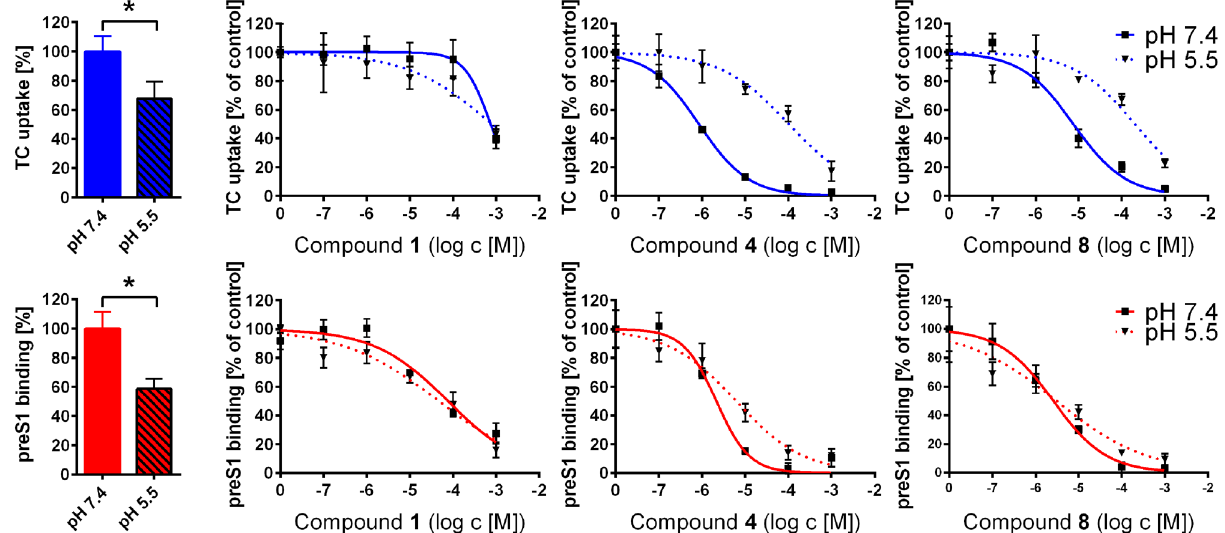
Figure 4. Influence of pH on the inhibition pattern of acidic betulin derivatives. NTCP-HEK293 cells were incubated with tetracycline in order to induce NTCP expression and were used for bile acid transport experiments with 1 µM [ 3 H]TC and for myr-preS1 2-48 lipopeptide binding experiments with 5 nM [ 3 H]preS1, each over 10 min at 37 °C. Cells without tetracycline treatment served as control (set to 0%). Experiments were performed with solvent alone (set to 100%) and with increasing concentrations of the indicated inhibitors in the range of 0.1 to 1,000 µM at pH 7.4 and pH 5.5, respectively. Diagrams show inhibition curves at pH 7.4 (solid lines) and pH 5.5 (dashed lines). The mean of the 0% control was subtracted to calculate net [ 3 H]TC transport rates (shown in blue) as well as net [ 3 H]preS1 binding rates (shown in red), both expressed as % of control at the y-axis. Bar graphs show the relative [ 3 H]TC uptake rates (blue bars) and [ 3 H]preS1 binding rates (red bars) at pH 7.4 (filled bars) and pH 5.5 (striped bars), respectively, expressed as pmol/10 min/well. Half maximal inhibitory concentrations (IC 50 ) were calculated by nonlinear regression analysis using the equation log(inhibitor) vs. response (GraphPad Prism). Data represent means ± SD of quadruplicate determinations (n = 4). *Significantly different with p < 0.01 (unpaired t-test with Welch’s